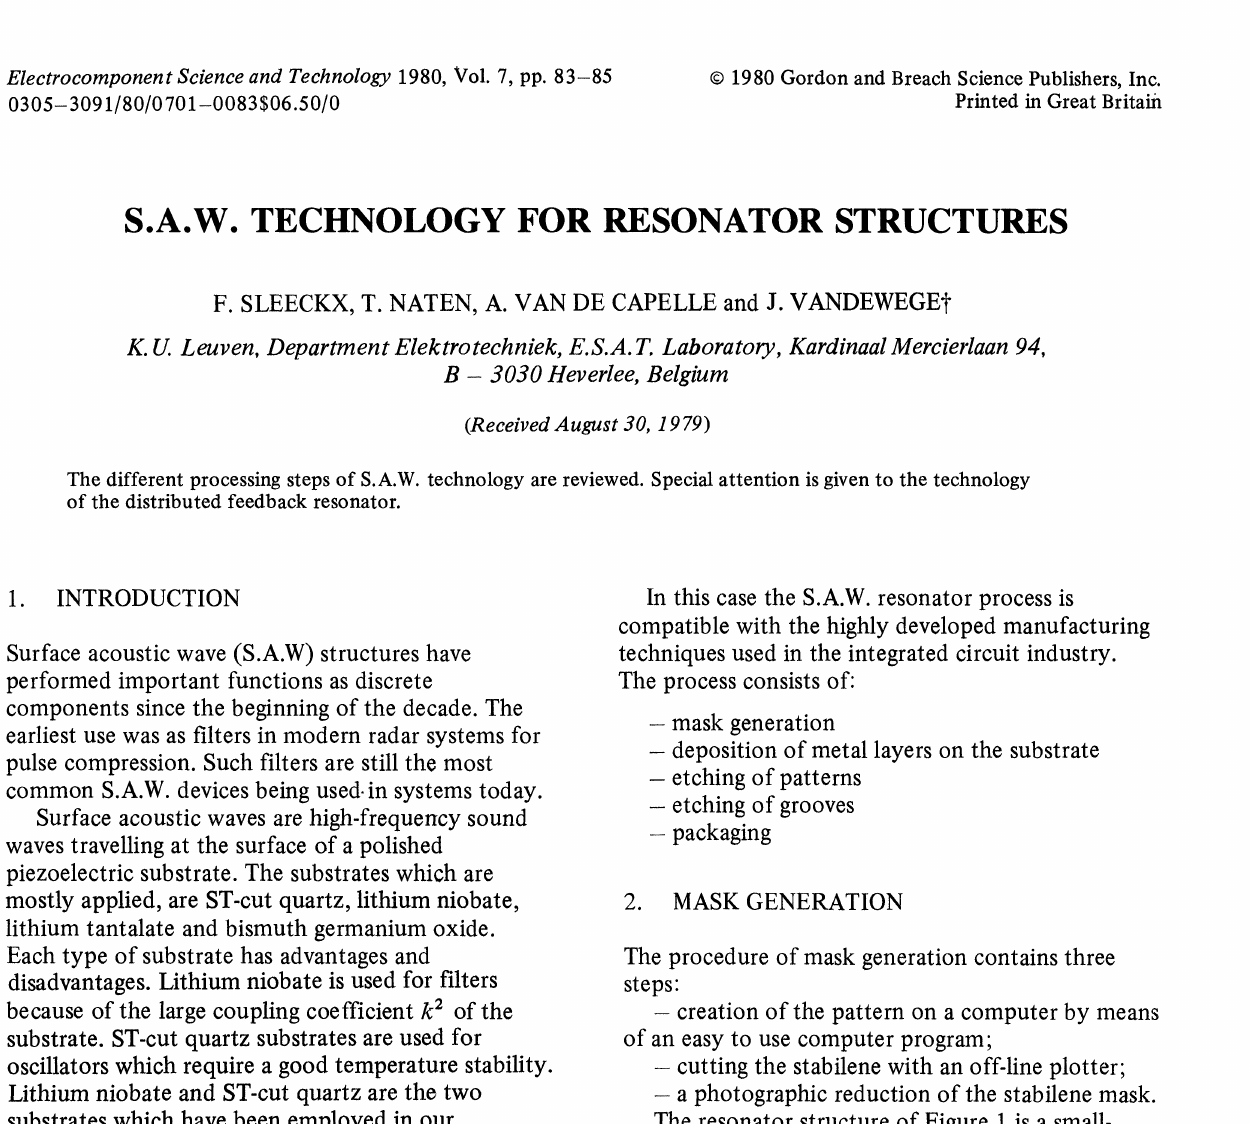
FIGURE Distributed feedback